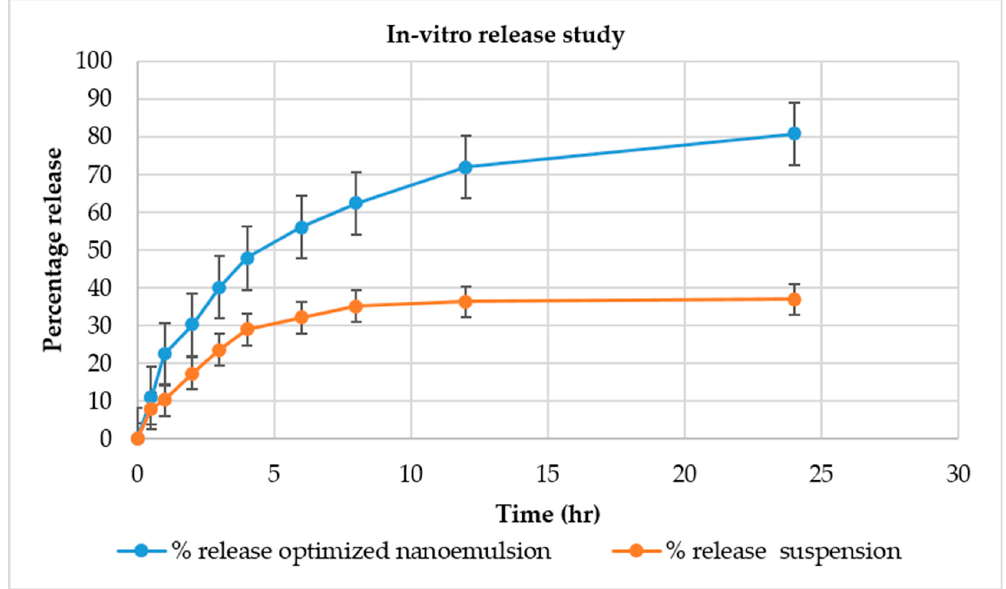
Gels 2022 , 8 , x FOR PEER REVIEW Figure 5. In vitro release study of optimized nanoemulsion and release suspension.